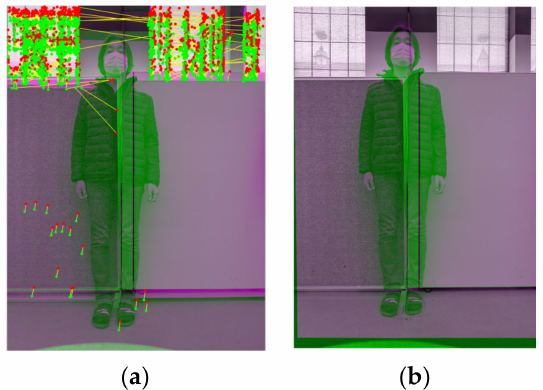
Figure 6. Background removal process. ( a ) Image registration using SURF feature points. ( b ) background registered onto subject’s